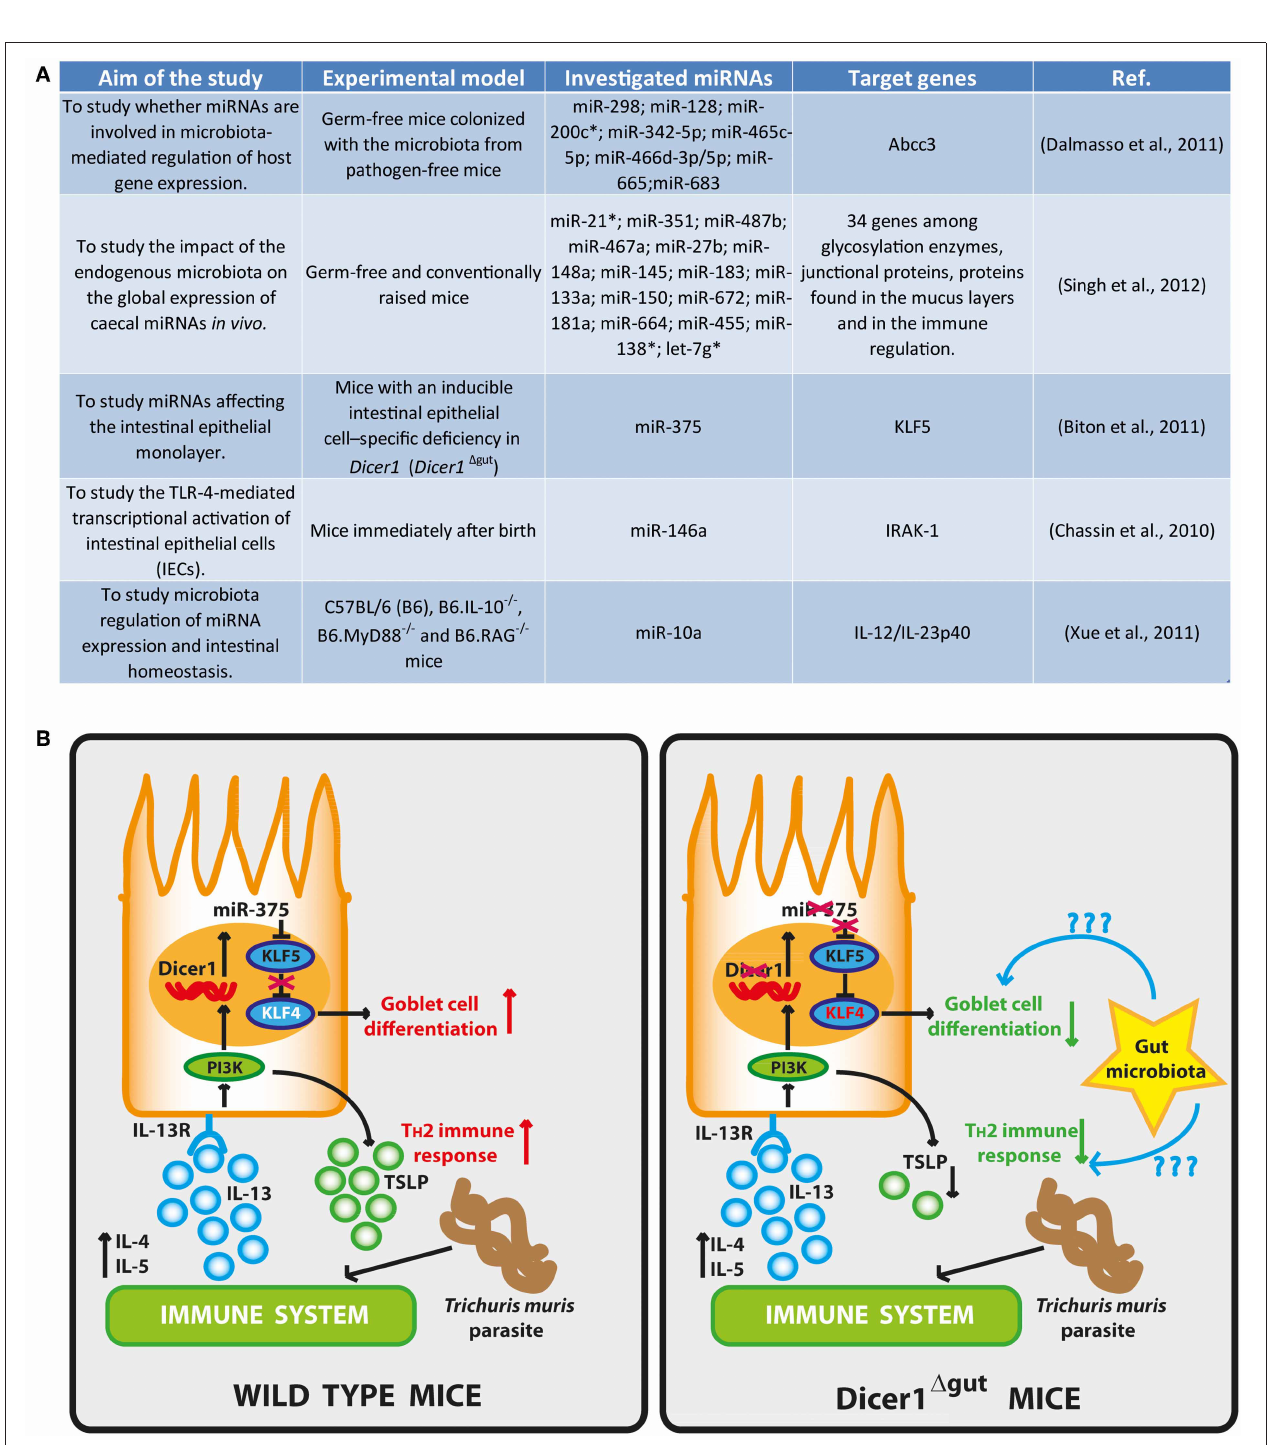
FIGURE 1 | (A) Research projects for the study of the interplays between gut microbiota and miRNAs. (B) Intestinal epithelial differentiation and T H 2 immune responses are regulated by miRNAs: in wild type mice, Dicer1 and miR-375 inhibit KLF5, a known antagonist of KLF4 that promotes the differentiation of goblet cells via KLF4. Helminth infection induces T H 2 cytokines, especially IL-13, which leads to epithelial expression of miR-375 and goblet-cell maturation via PI3K. Moreover, miR-375 also induces TSLP to